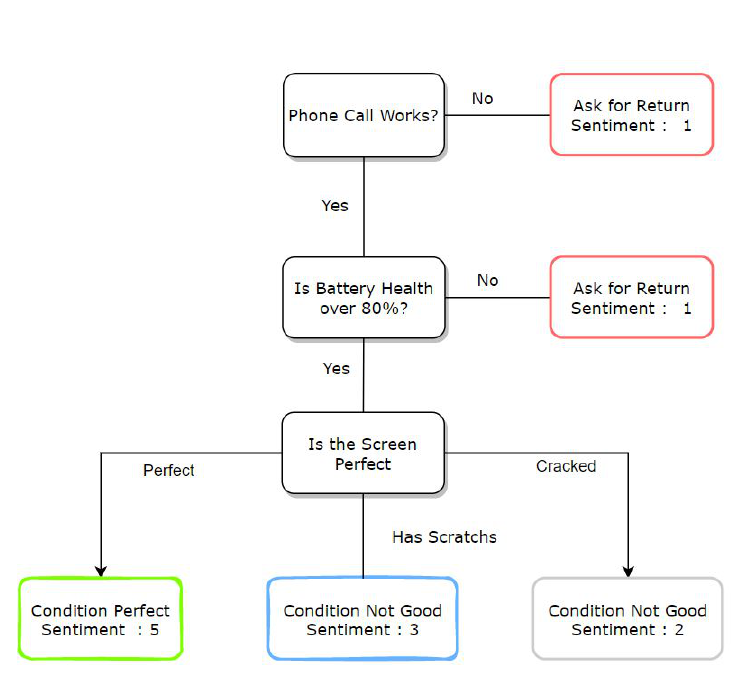
Figure A1. Decision tree for phone sentiment classification.